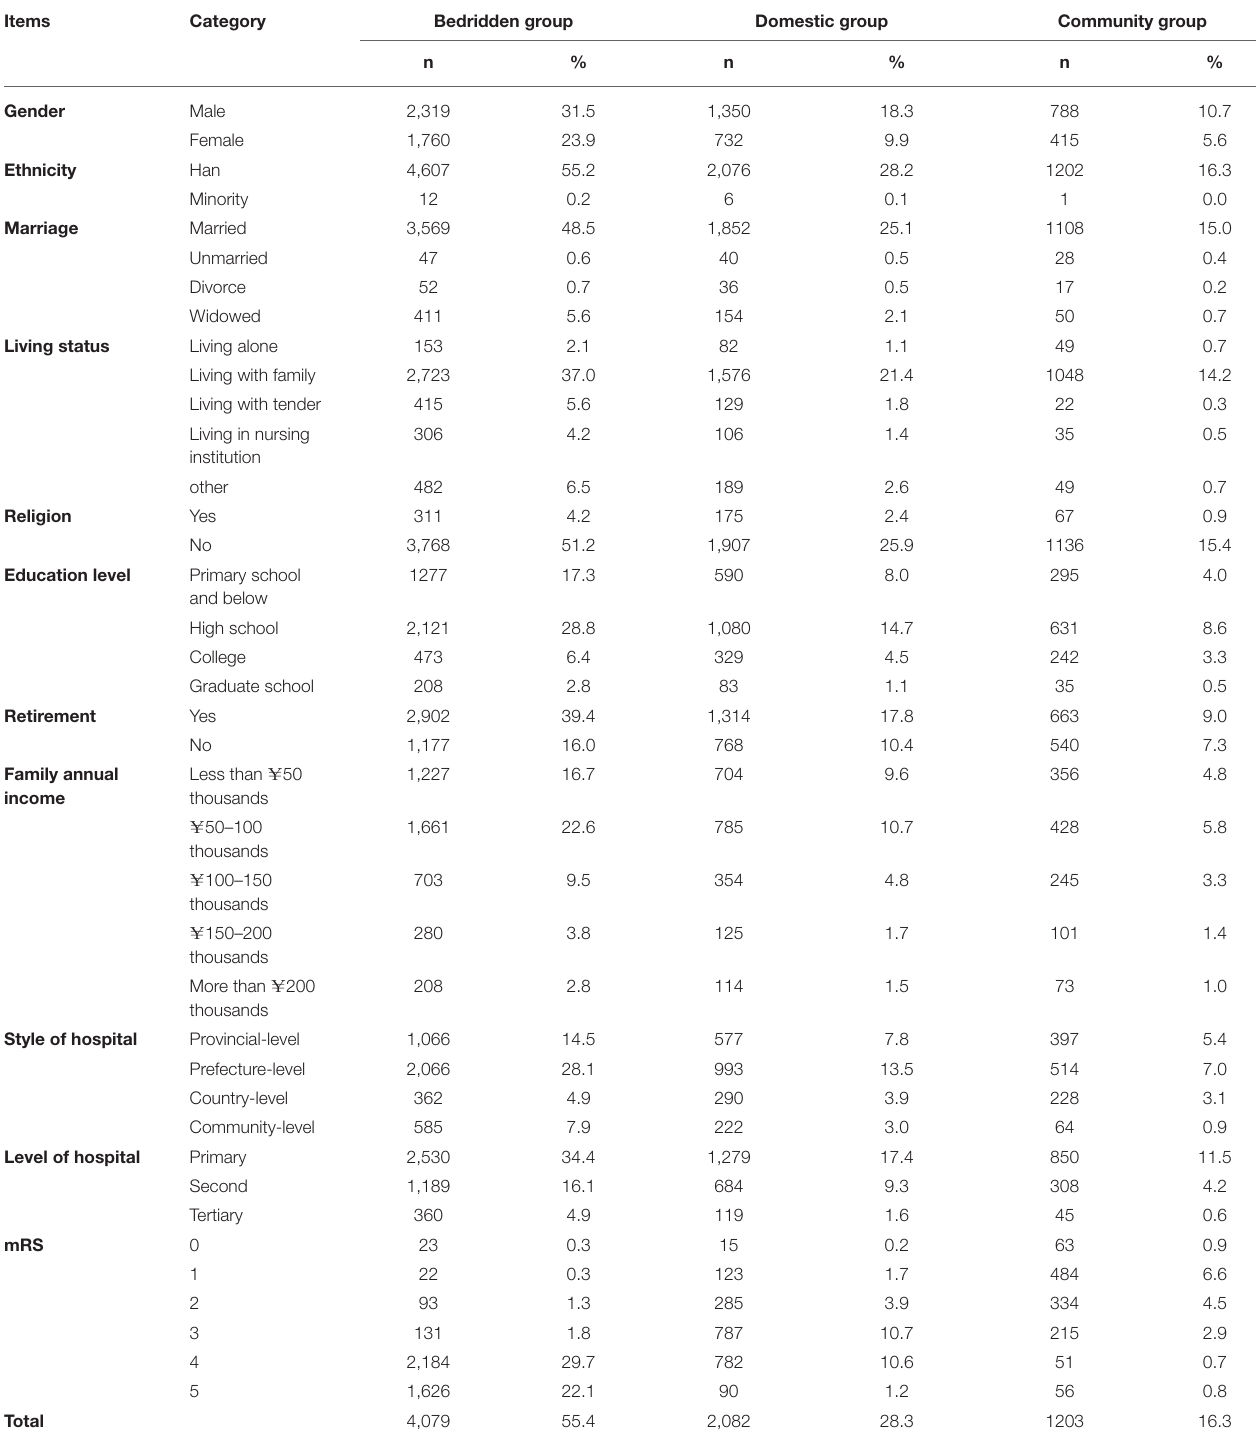
TABLE 1 | The sociodemographic characteristics of surveyed stroke patients.